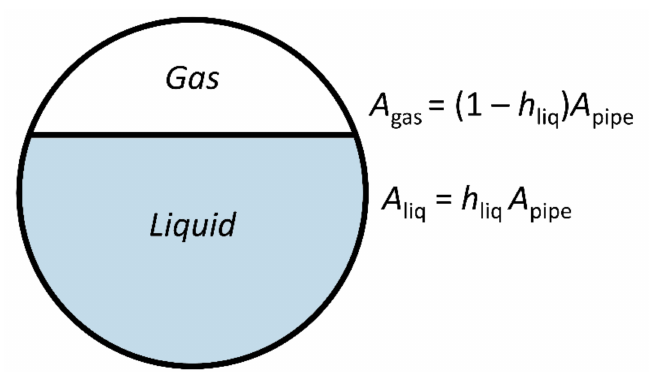
Figure 1. Schematic representation of the definition of the liquid holdup h liq .